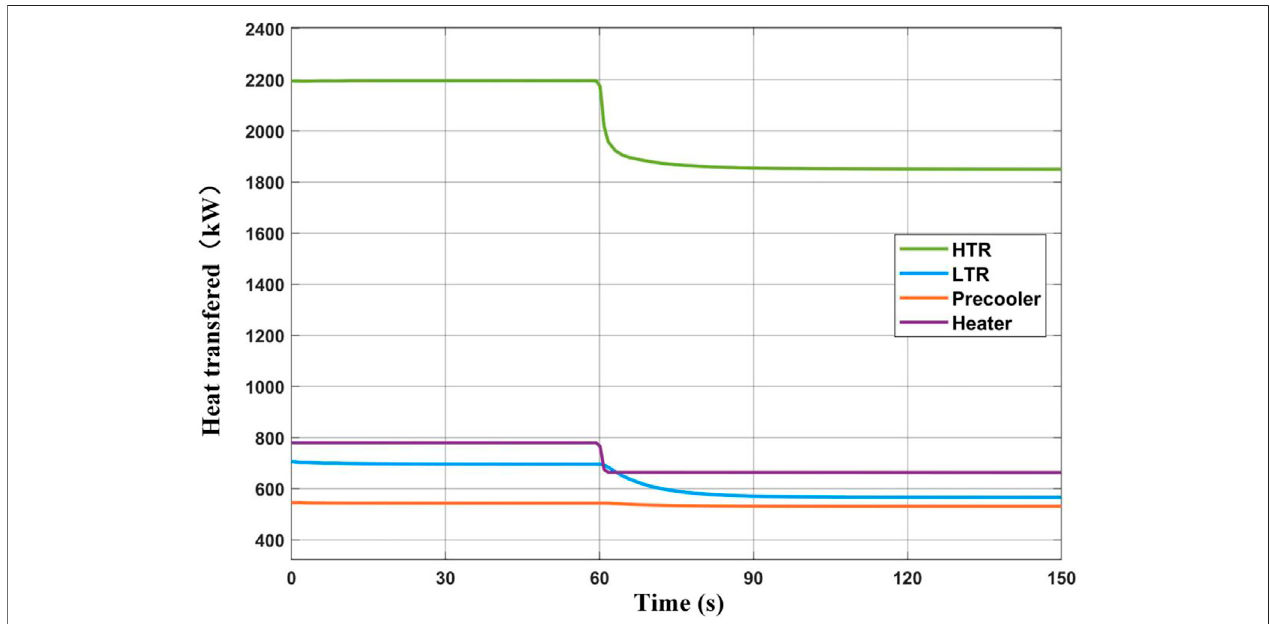
FIGURE 4 | Dynamic response of heat transfer in heat exchangers while reducing heat source power.